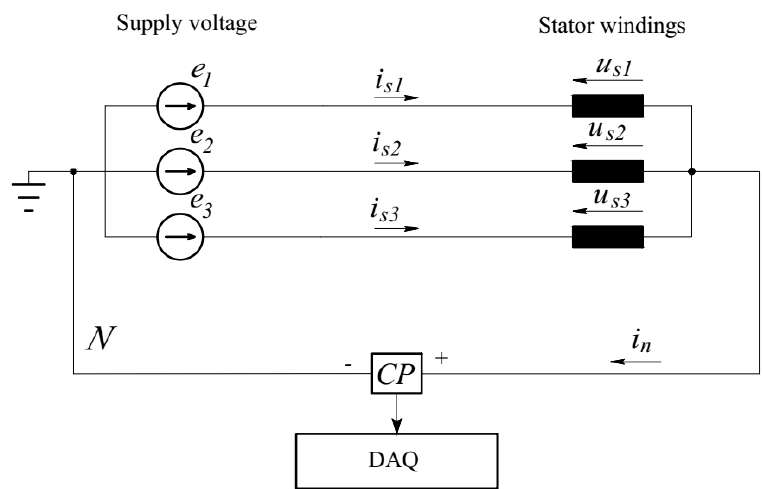
Figure 2. The zero-sequence current component measurement circuit for a machine with a wye winding connection with neutral wire, where e 1 , e 2 , e 3 are supply phase voltages; i s 1 , i s 2 , i s 3 are stator phase currents; u s 1 , u s 2 , u s 3 are voltages induced in stator phase windings; i n is a neutral wire current; (cid:1829)(cid:1842) is a neutral point of supplying voltages; (cid:1829)(cid:1842) is a current probe; (cid:1830)(cid:1827)(cid:1843) is a data acquisition system.